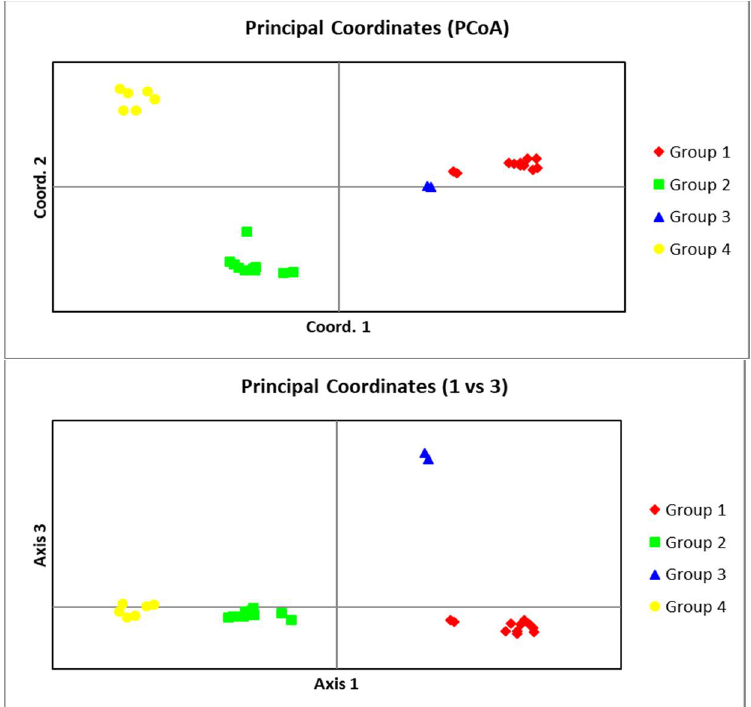
Figure 7. The bi-dimensional dispersion according to the principal coordinates analysis obtained using the GenAlex software (Above: PC1 vs. PC2, below: PC1 vs. PC3) for Meloidogyne javanica populations from Iran. Table 8. Pairwise estimate of F ST and N m among four groups of the populations of Meloidogyne javanica from